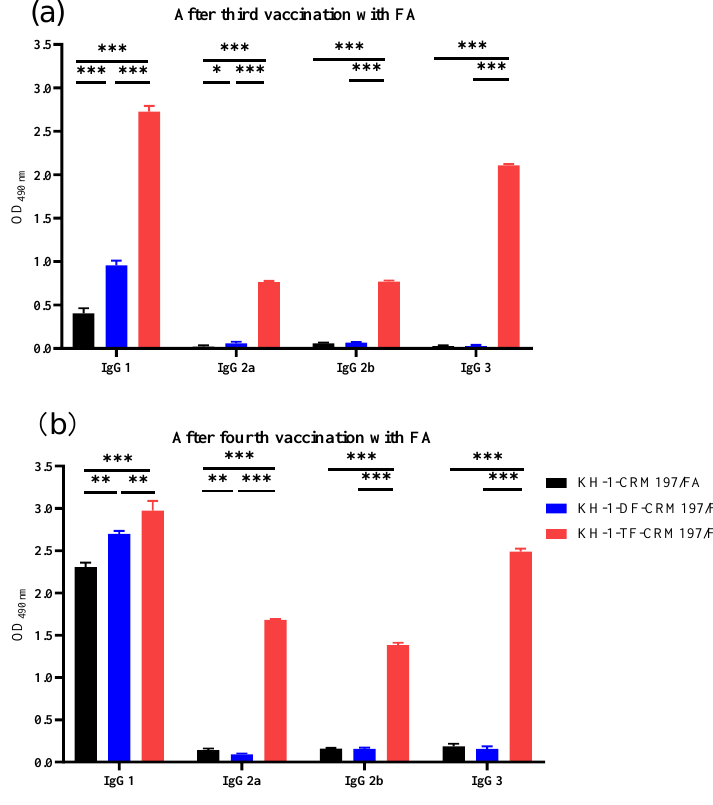
Figure 3. IgG subtypes after the third ( a ) and fourth ( b ) vaccinations with KH-1-KLH, KH-1-DF-KLH, and KH-1-TF-KLH with Freund’s adjuvant using ELISA with a 1:1000 dilution of pooled sera. Results represent the mean ± SEM of three independent experiments. One-way ANOVA analysis was performed. * p < 0.05, ** p < 0.01, *** p < 0.01.